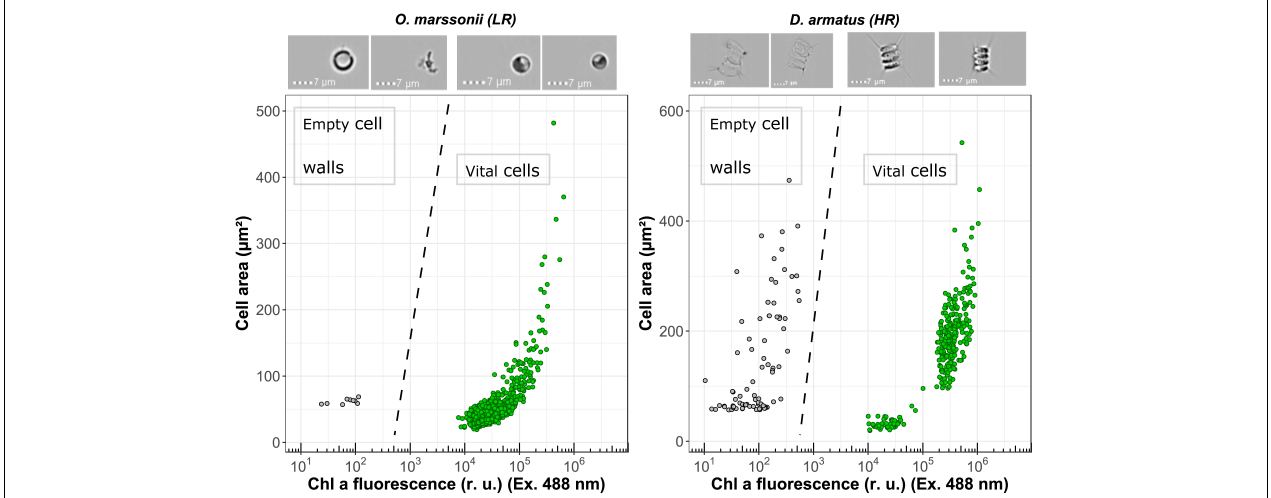
FIGURE 3 | Flow cytometric measurements of Chl a fluorescence (Excitation 488 nm) and cell surface area for O. marssonii and D. armatus . Accumulation of enzymatic resistant empty cell walls is demonstrated by the population on the upper left-hand side. Representative microscopic pictures for the respective populations are placed on the top of the